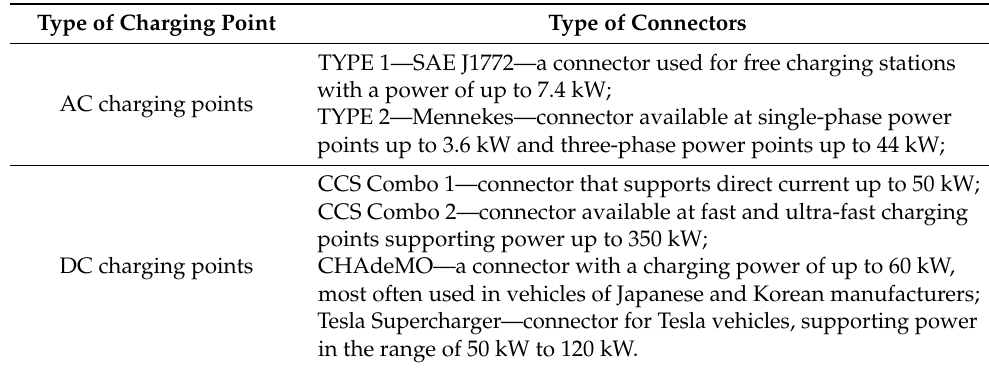
Table 2. Type of connectors available at public charging points.